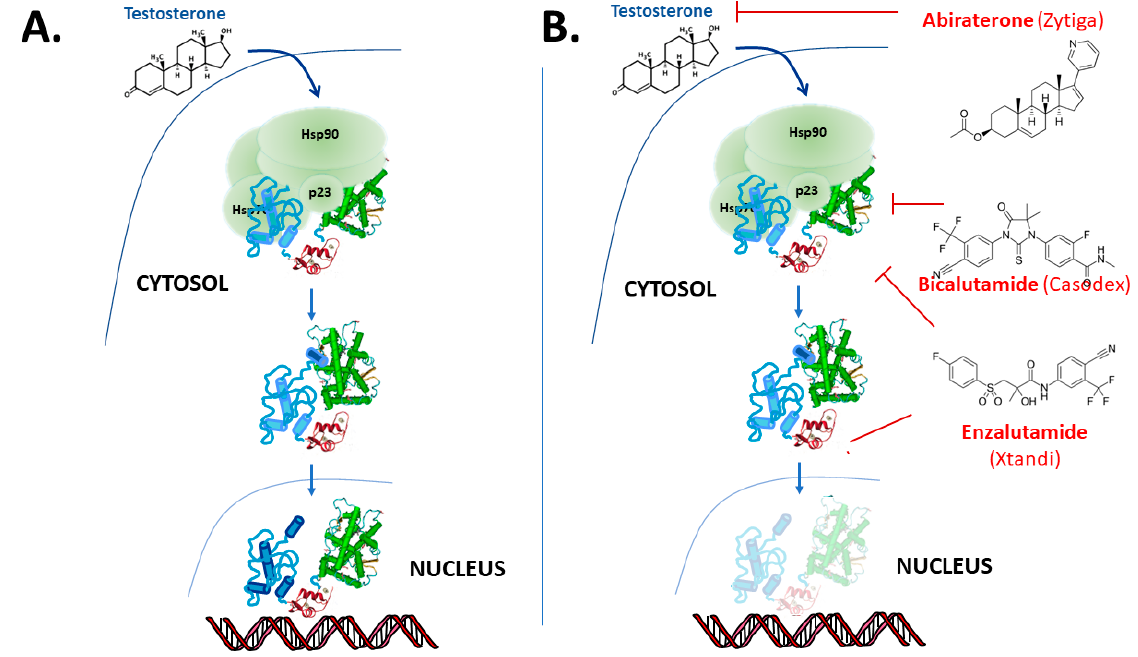
Figure 2. Overview of androgen receptor mechanism of action. ( A ) In the “classical” model the AR binds to testosterone and in tissues such as the prostate preferentially to the more potent metabolite 5 α -dihydrotestosterone (DHT) and dissociates from molecular chaperones and translocates to the nucleus where it binds to DNA response elements and up- or down-regulates target gene expression. However, the details of a number of these steps in this model remain subject to debate and on-going research. ( B ) The action of the drugs abiraterone, bicalutamide and enzalutamide used in the treatment of PCa.